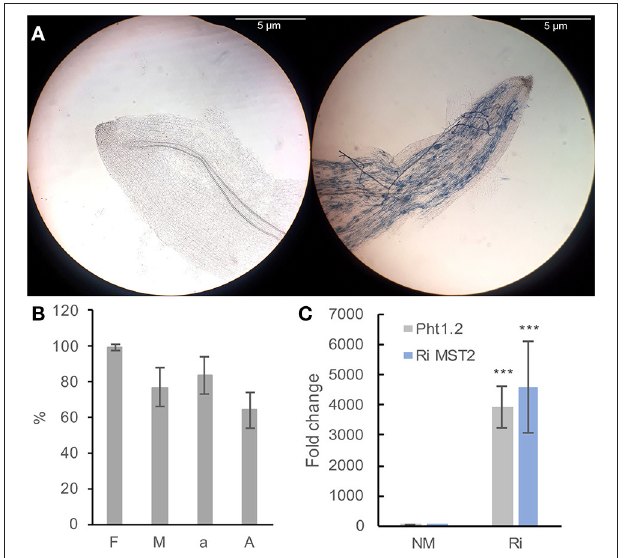
FIGURE 2 | Plant mycorrhization parameters (A,B) and expression of colonization marker genes in grapevine roots (B) . (A) Representative pictures of Ri (right) and NM (left) roots. Pictures were taken with a Nikon ALPHAPHOT-2 microscope (X100 magnification). Bar = 5 µ m. (B) F (frequency): percentage of colonized fragments, M (intensity): proportion of hyphae in the root cortex, a: arbuscule content in colonized roots, A: arbuscule abundance in the whole root system (from Trouvelot et al., 1986). Data are the mean ± SD of 12 biological replicates. (C) Expression of the grapevine Pht1.2 phosphate transporter and the R. irregularis RiMST2 hexose transporter in roots of NM and Ri plants. Expression was studied by RT-qPCR in root tips 2 months after mycorrhization. Transcript levels were normalized to V. vinifera ACTIN and EF1 α transcript levels. Fold change (2 − 11 CT method) indicates normalized expression levels in Ri roots compared to the mean of the normalized expression levels measured in NM roots. Data are the mean ± SD of 12 biological replicates. Asterisks indicate significant difference in gene expression between NM and Ri conditions (Kruskall and Wallis, p < 0.001).